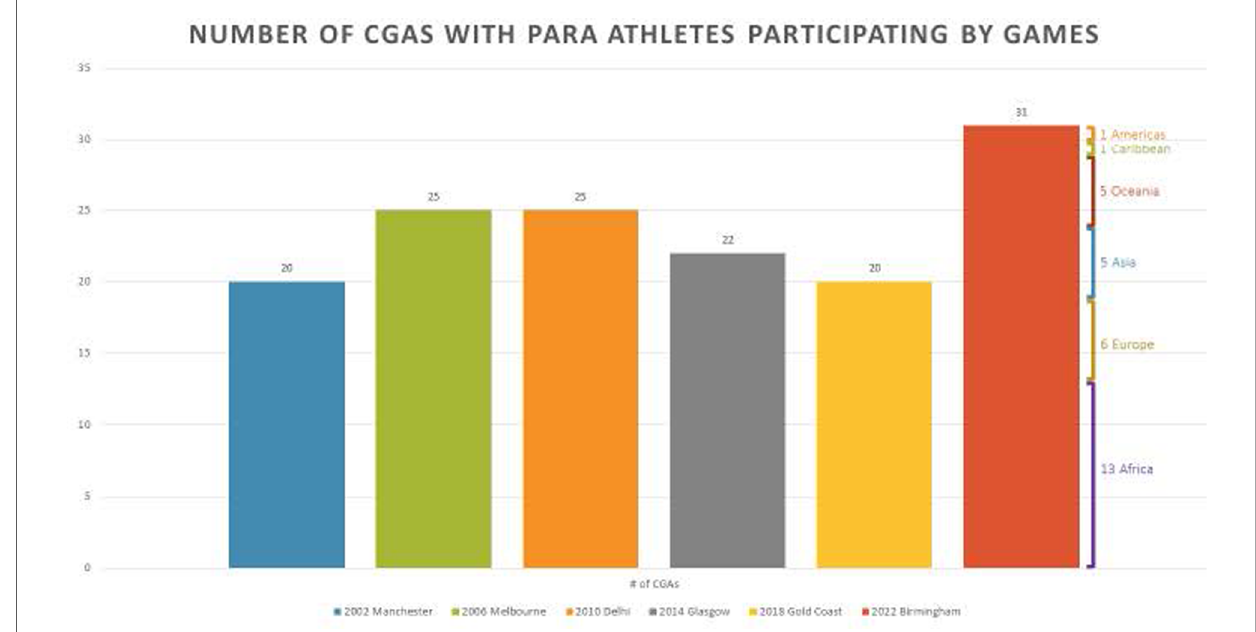
FIGURE 3 CGA ’ s with para sport representation at CG 2002 to 2022. Figure 3 was prepared by CGF post B2022 titled pam sport analysis: for the purposes of understanding the impact of GAPS on Birmingham